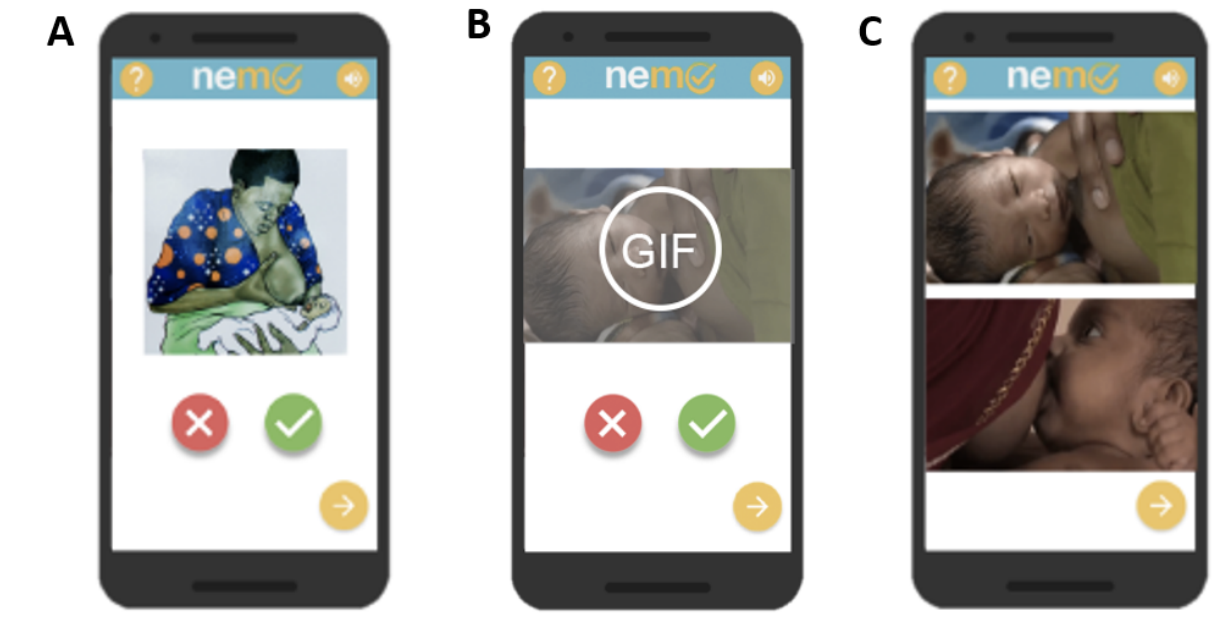
Adjustable strap, n (%)Velcro-with-loop, n (%)Velcro, n (%)Embodiment